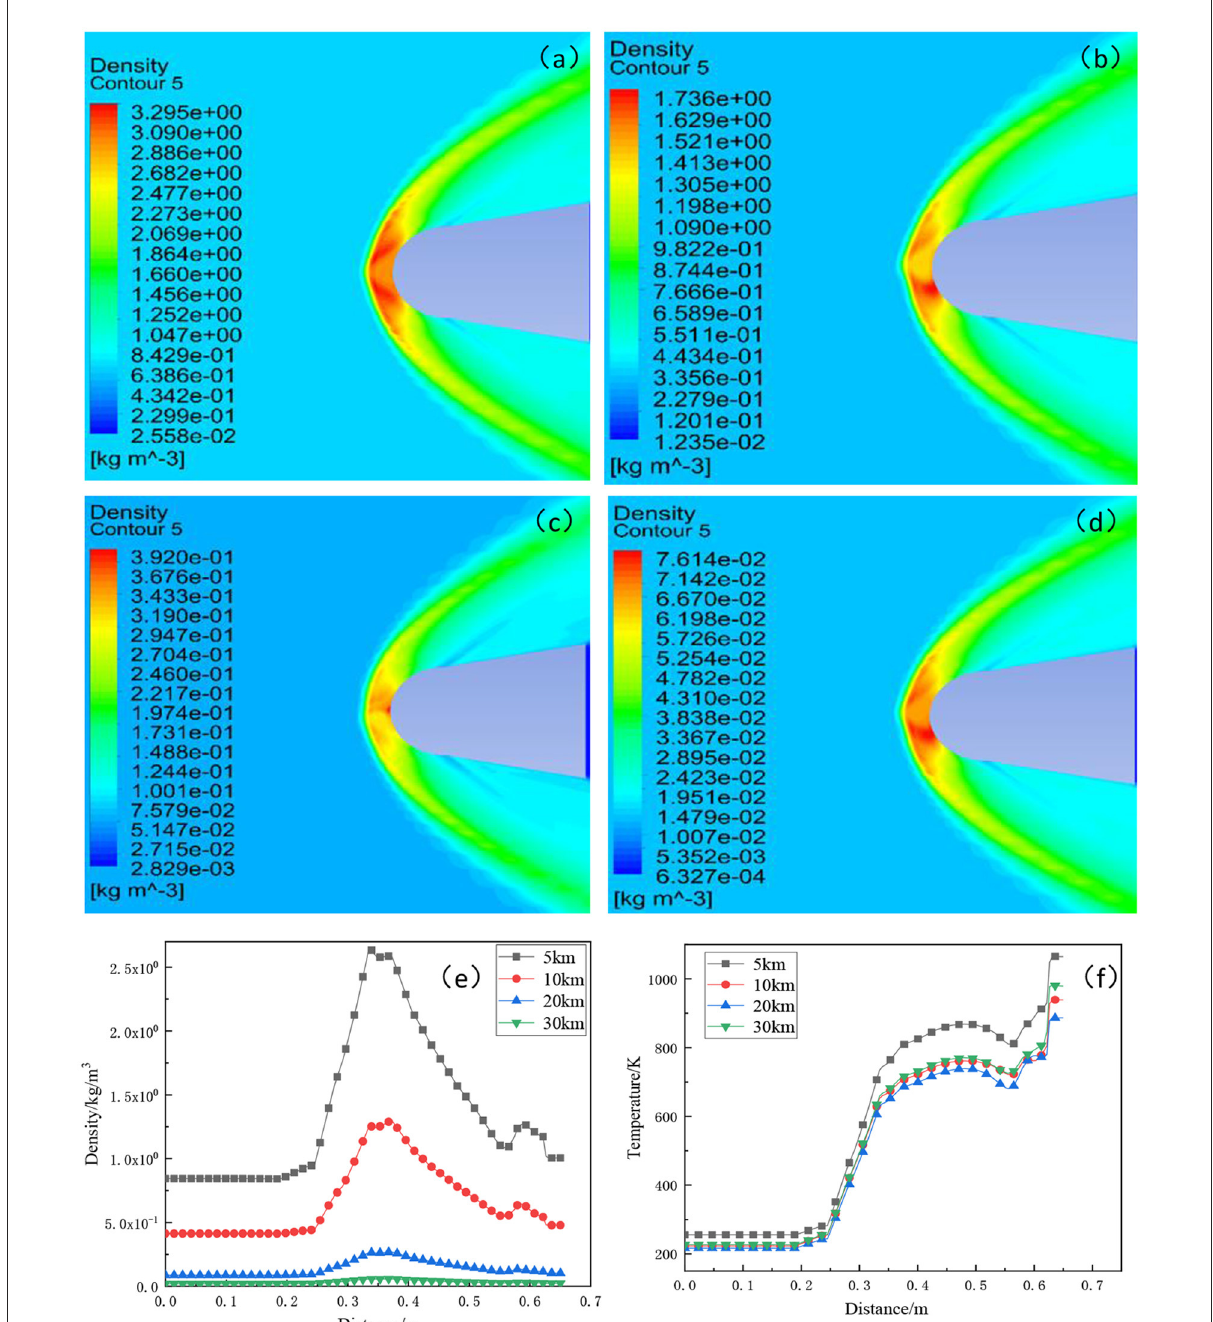
FIGURE2 Comparison of density distribution of hypersonic vehicle disturbed flow field at different altitudes. (a) 5km; (b) 10km; (c) 20km, and (d) 30km. Distribution of density and temperature at different flight altitudes (5, 10, 20, 30km) at a flight speed of Mach 5. (f) density trend and (e) temperature